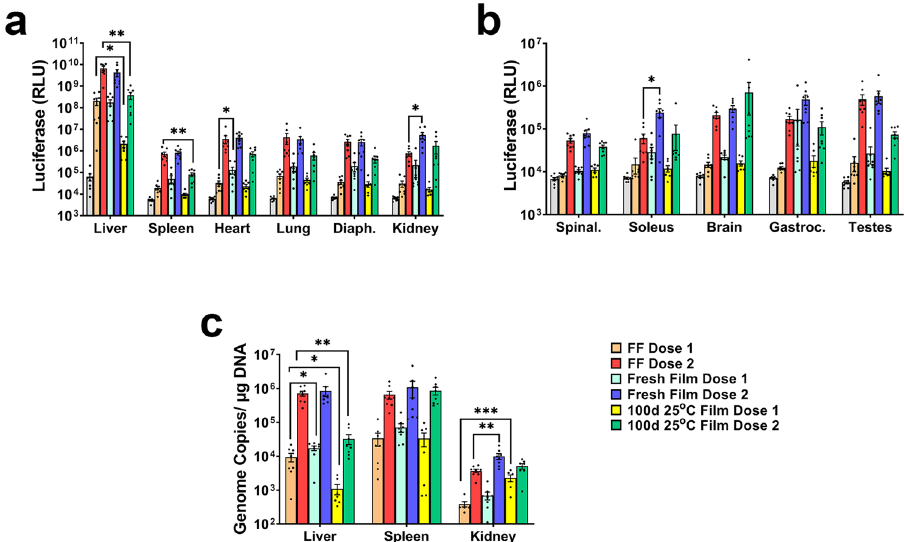
Fig. 8 AAV stabilized in a thin fi lm for 100 days at room temperature induces transgene expression in a dose-dependent manner. Freshly prepared and aged fi lms created with the high-viscosity formulation were rehydrated and diluted with saline to administer 1 × 10 10 (Dose 1) or 1 × 10 11 (Dose 2) virus genomes of AAV9 CBA-Luc by tail vein injection. a , b Luciferase transgene expression in target organs 30 days after administration assessed by bioluminescence imaging. Mean (±standard error of the mean) values for total fl ux for each organ are shown. Signi fi cant differences between animals treated with each dose of the Standard Control Formulation (FF) and the equivalent dose of fresh fi lms and 100-day old fi lms made from the F1S formulation were evaluated by one-way ANOVA with Dunnett ’ s multiple comparison tests. c Organs with high transgene expression were further analyzed for virus genome copies by quantitative real-time PCR. Data re fl ect the mean (±standard error of the mean) values for each treatment group. Signi fi cant differences between subgroups with respect to dose were evaluated by one-way ANOVA with Dunnett ’ s multiple comparison tests. a , b Diaph diaphragm, Spinal spinal cord, gastroc gastrocnemius muscle * p < 0.05, ** p < 0.01, *** p <